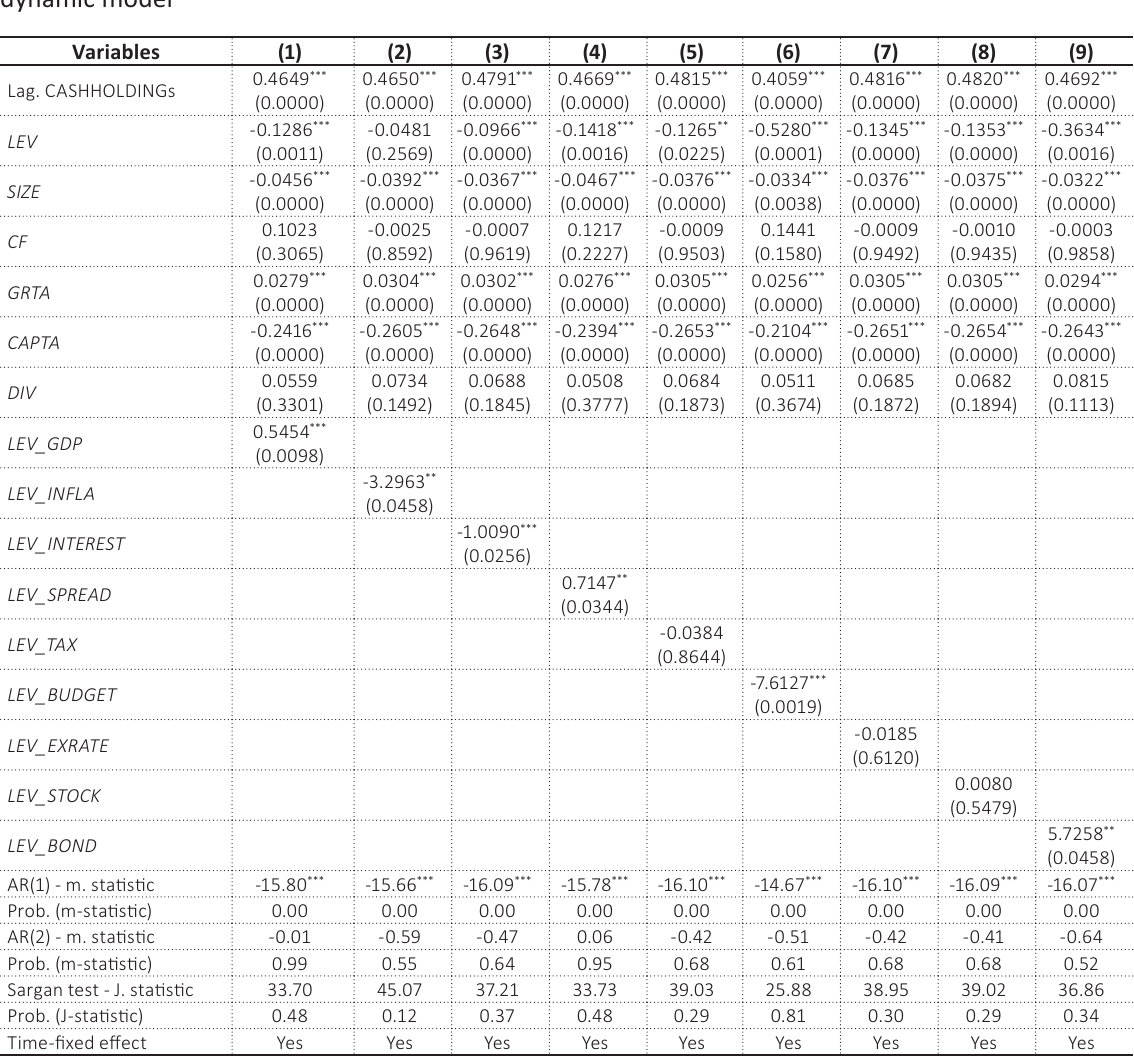
Table 8. Influence of debts on corporate cash holdings according to macroeconomic factors in a dynamic